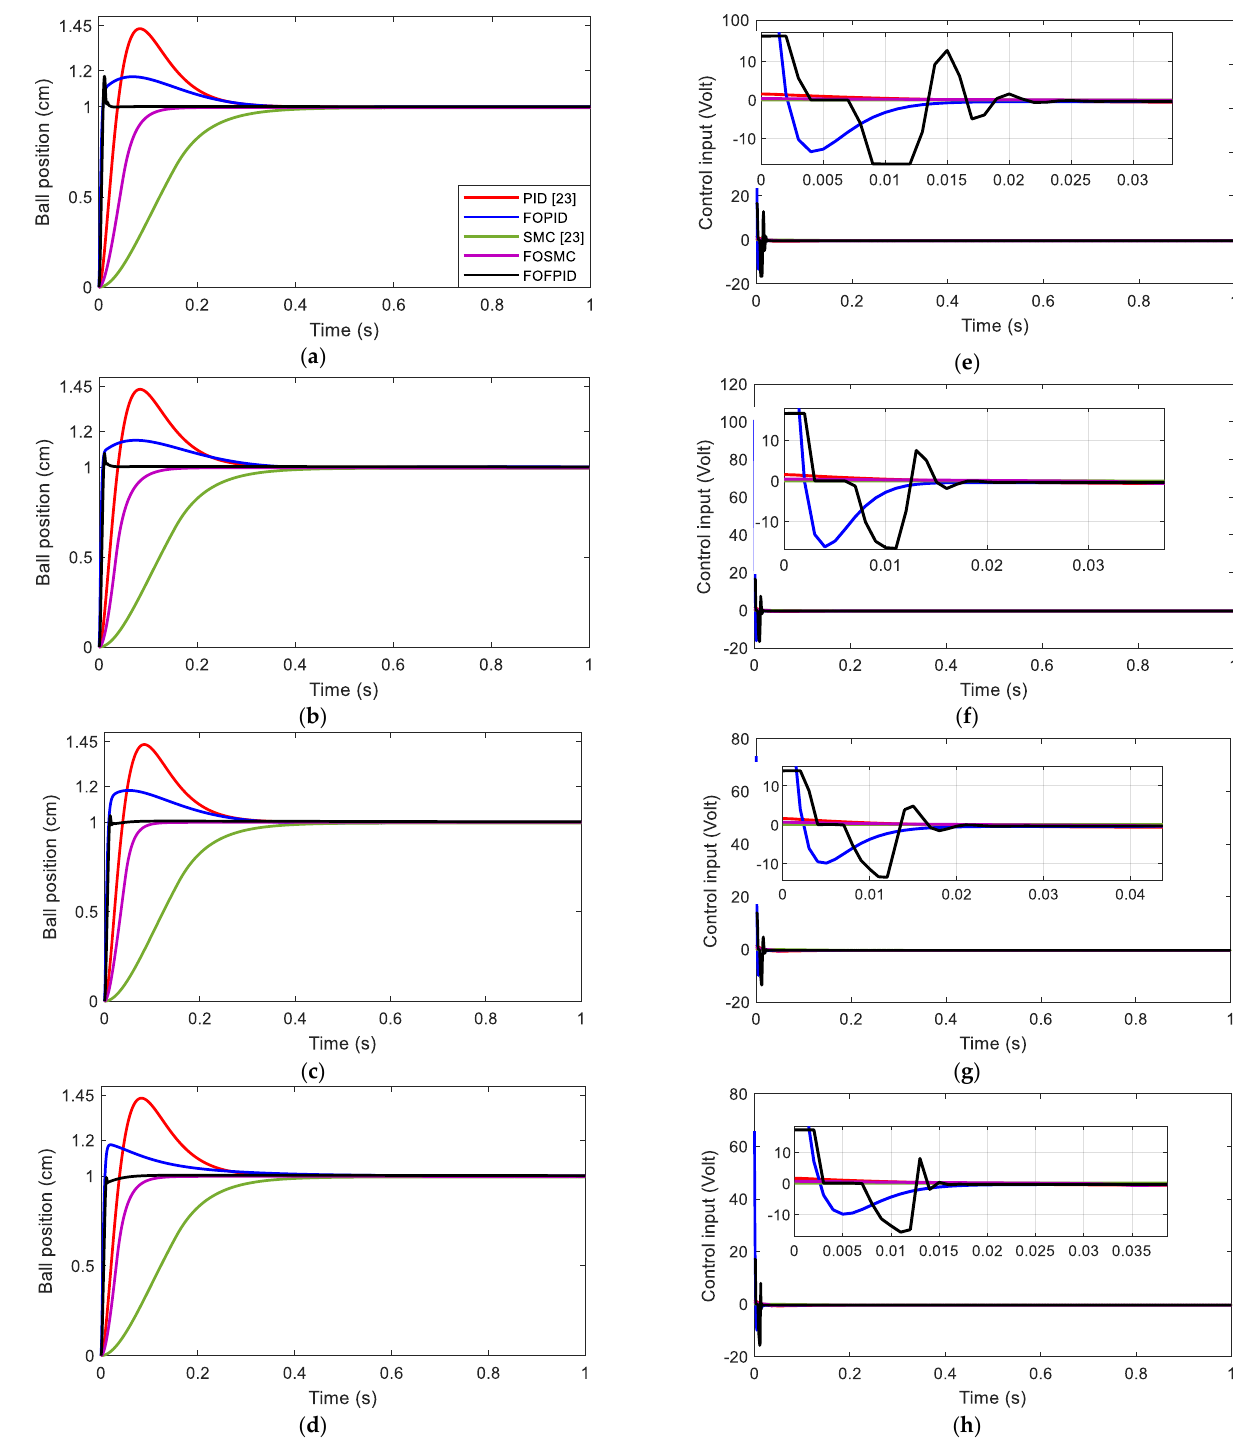
Figure 8. Closed-loop responses ( a – d ) and control efforts ( e – h ) for the Maglev system with different controllers based on 𝐽 𝐼𝐴𝐸 ( a , e ), 𝐽 𝐼𝑆𝐸 ( b , f ), 𝐽 𝐼𝑇𝐴𝐸 ( c , g ) and 𝐽 𝐼𝑇𝑆𝐸 ( d , h ) under parametric variation with +10%.